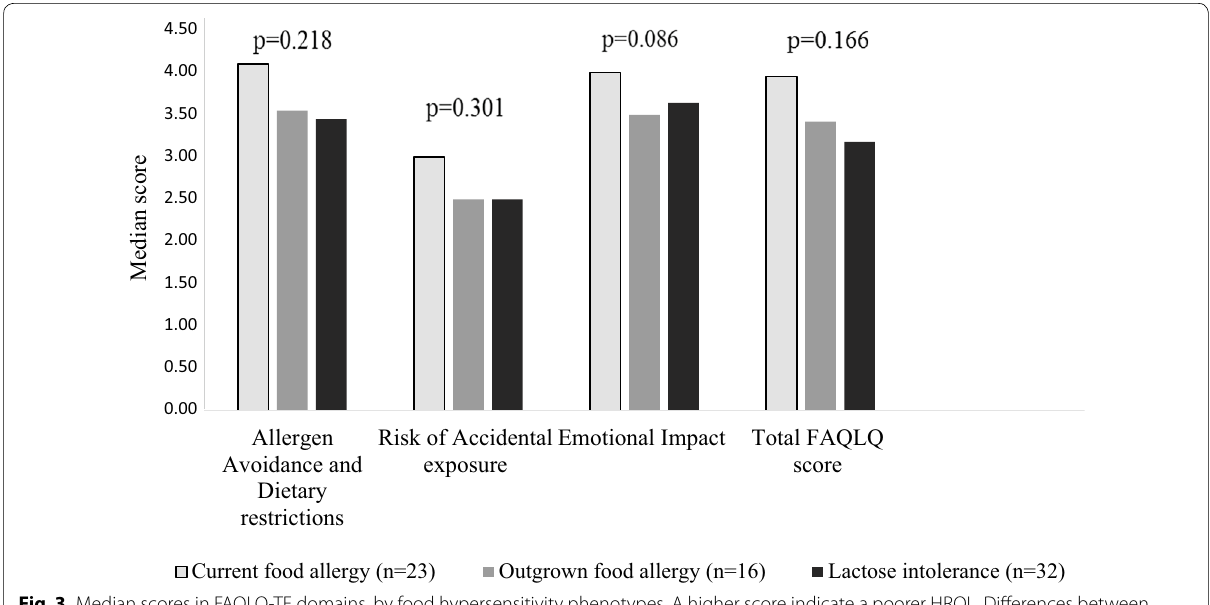
Fig. 3 Median scores in FAQLQ‑TF domains, by food hypersensitivity phenotypes. A higher score indicate a poorer HRQL. Differences between groups was analysed by the Kruskal–Wallis test. The score range of FAQLQ‑TF is between 1 (best HRQL) and 7 (worst HRQL)